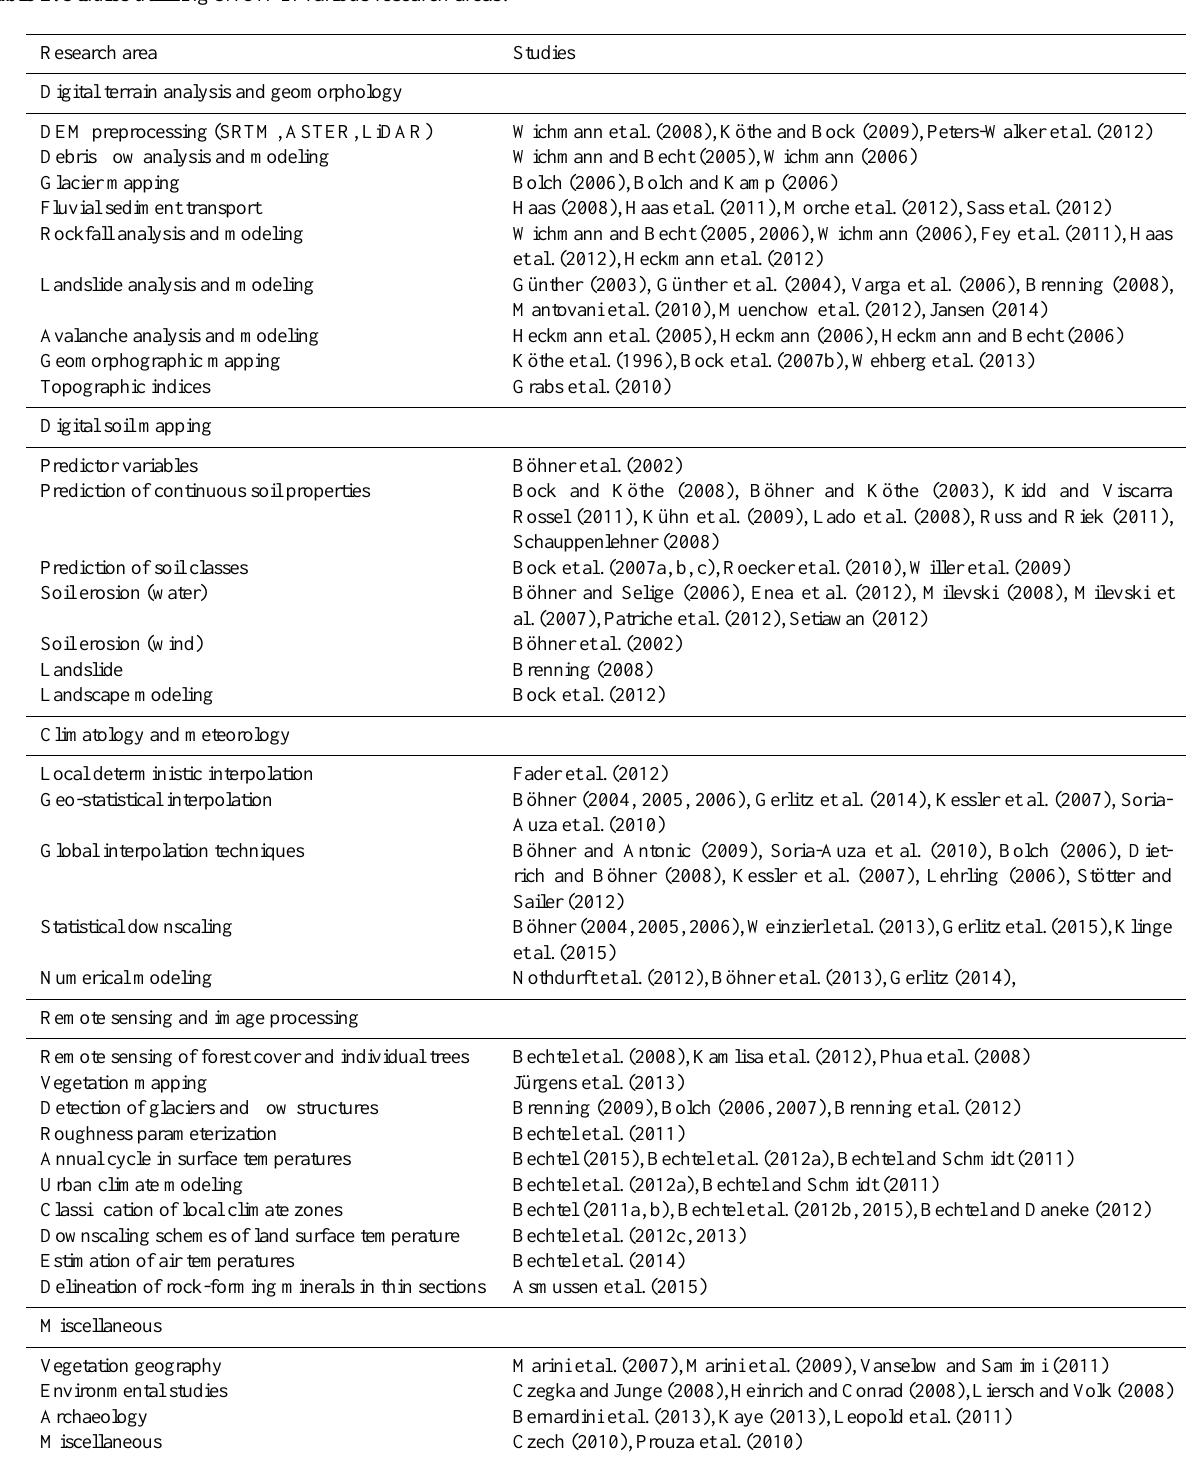
Table 2. Studies utilizing SAGA in various research